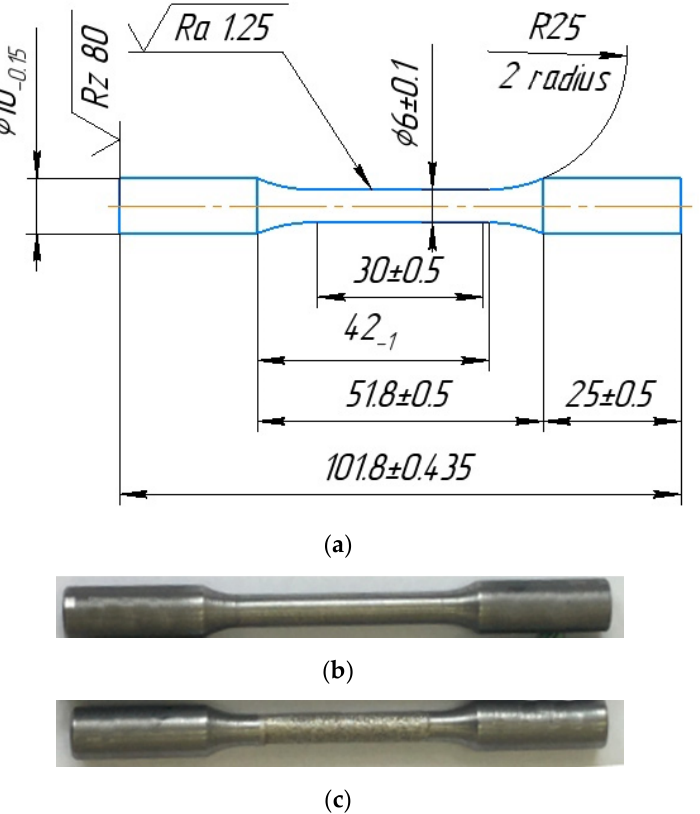
Figure 7. Sketch ( a ) and photographs of samples, the working parts of which were processed by turning ( b ) and EDM ( c ) methods.